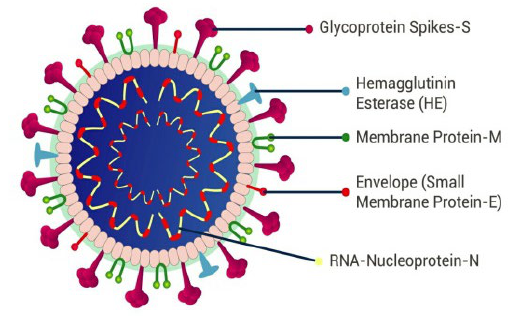
Figure 1 . Structure of Coronavirus Genome